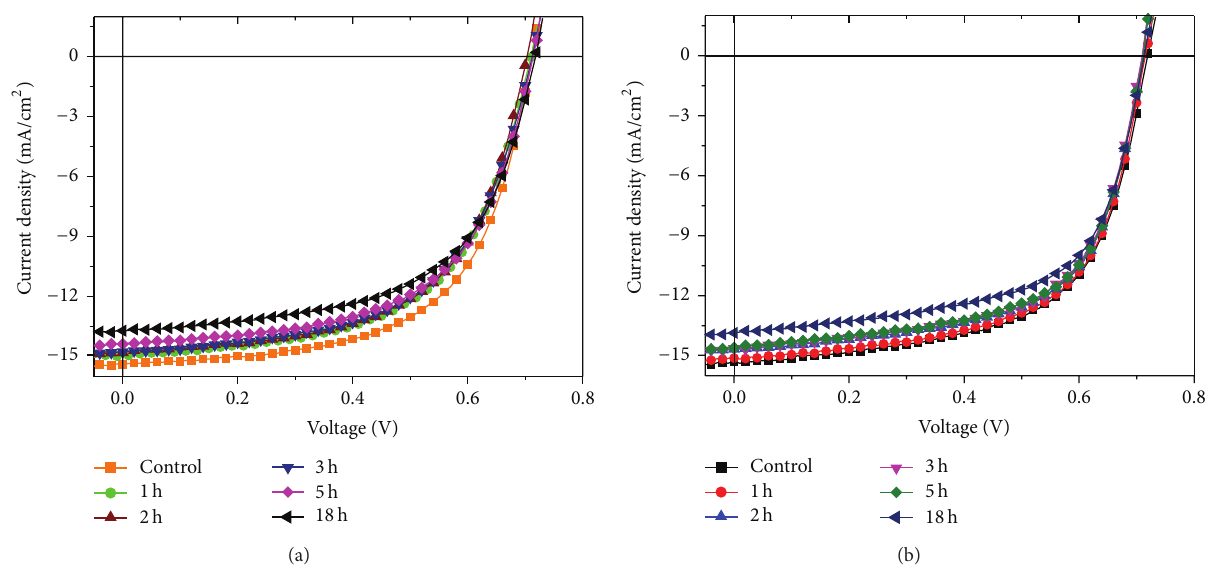
Figure 4: J-V curves of the (a) conventional and (b) inverted solar cells treated at 70 ∘ C for different time.